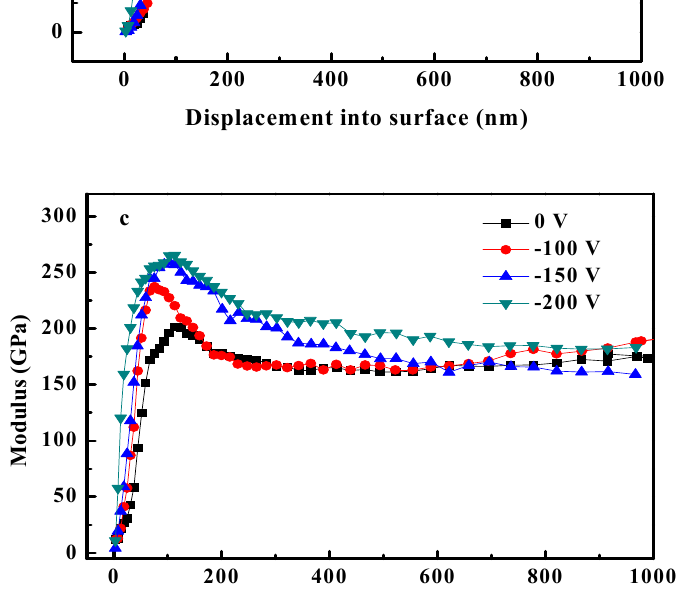
Young’s modulus–displacement curves ( c ) of uncoated 316L SS and 316L SS with HfC coatings Figure 7. Nanoindentation load–displacement curves ( a ), hardness–displacement curves ( b ), and